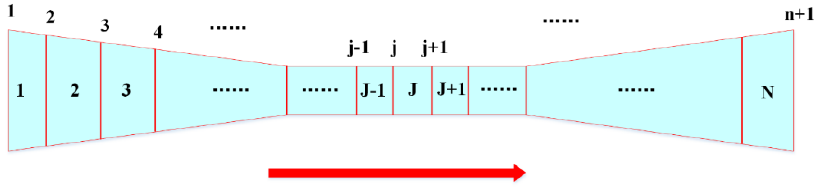
Figure 2. Schematic of grids in the mixing section.